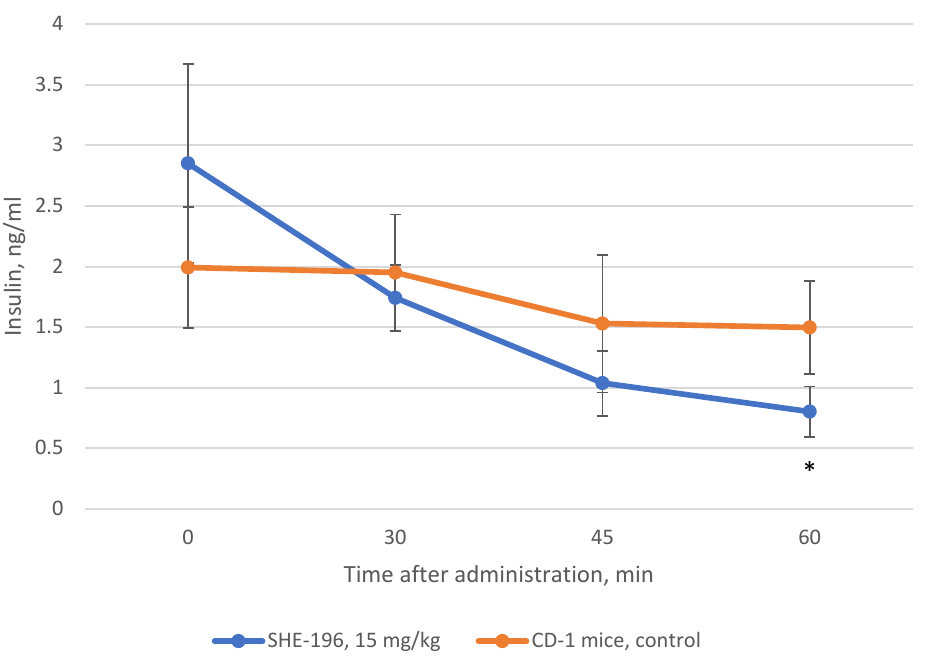
Figure 8. Change in insulin blood concentration after single oral introduction of SHE-196 at a dose of 15 mg/kg in CD-1 mice. * p < 0.05 compared to control animals .